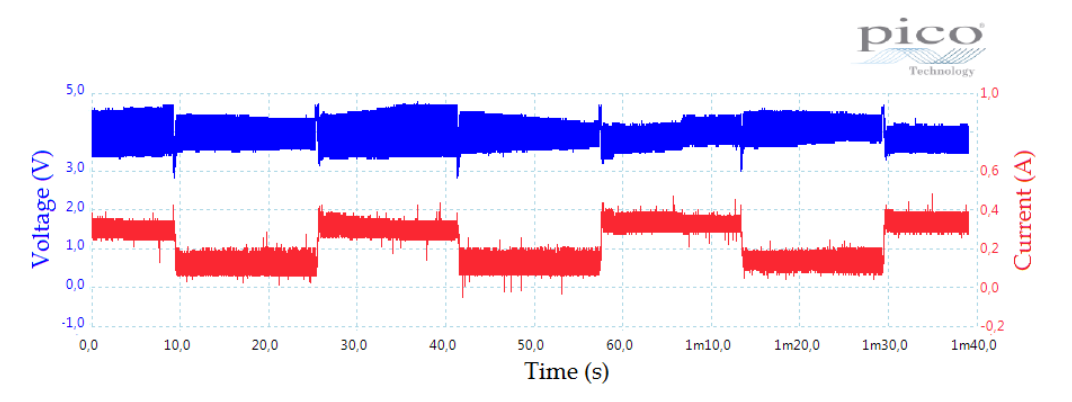
Figure 13. PV voltage and current time evolution by employing the P&O method.